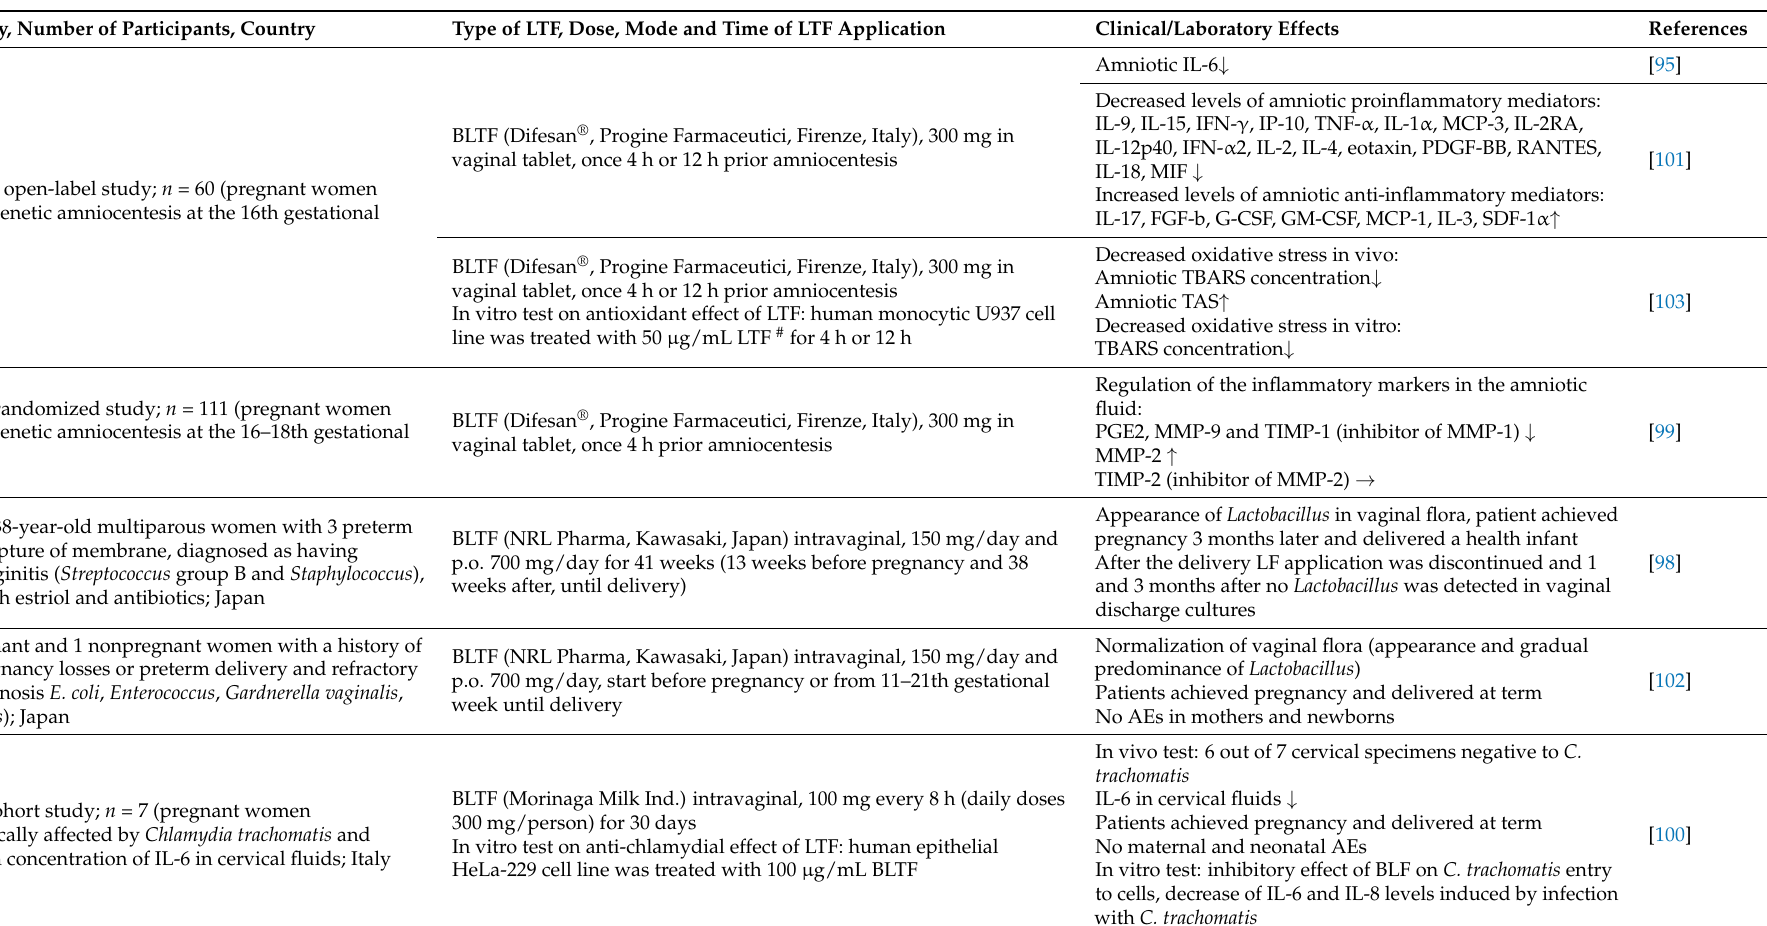
Table 2. Clinical studies with BLTF in prophylaxis and therapy of pregnant women suffering from infection and